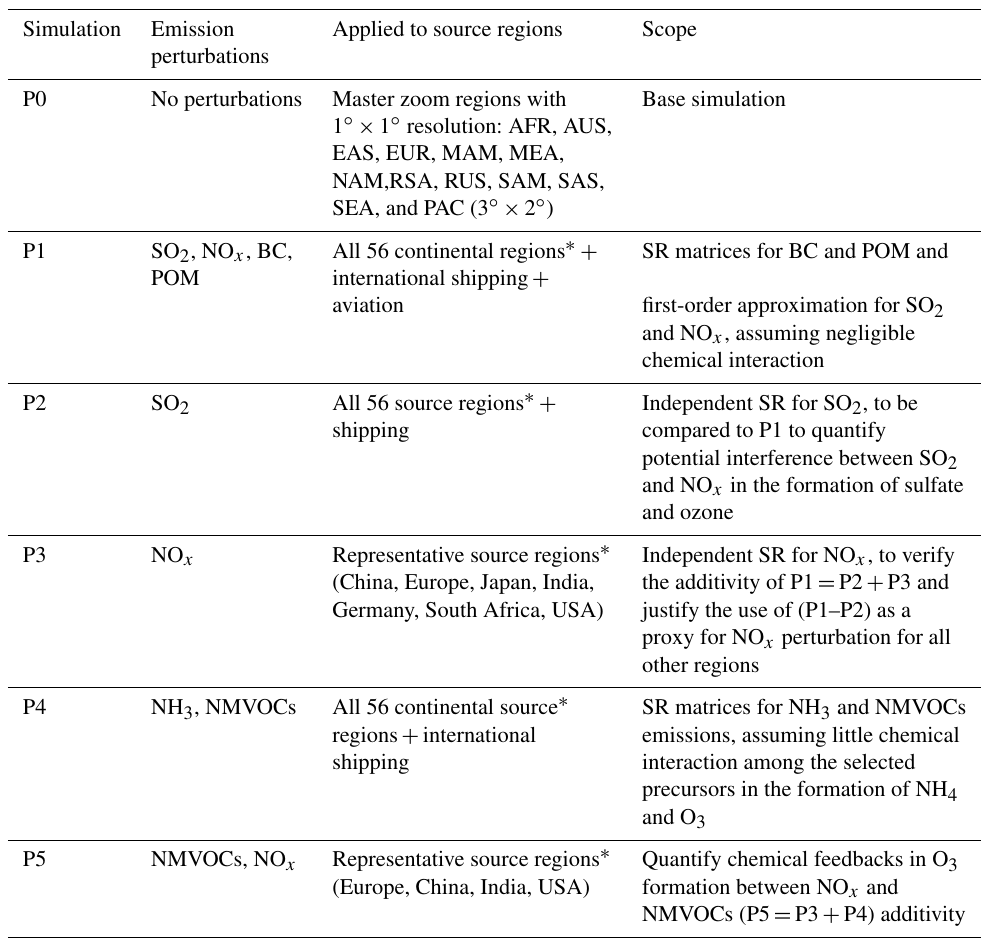
Table 2. Overview of TM5 CTM perturbation simulations (20% emission reduction) for the calculation of the source–receptor (SR) matrices. Simulation Emission Applied to source regions Scope Master zoom regions with